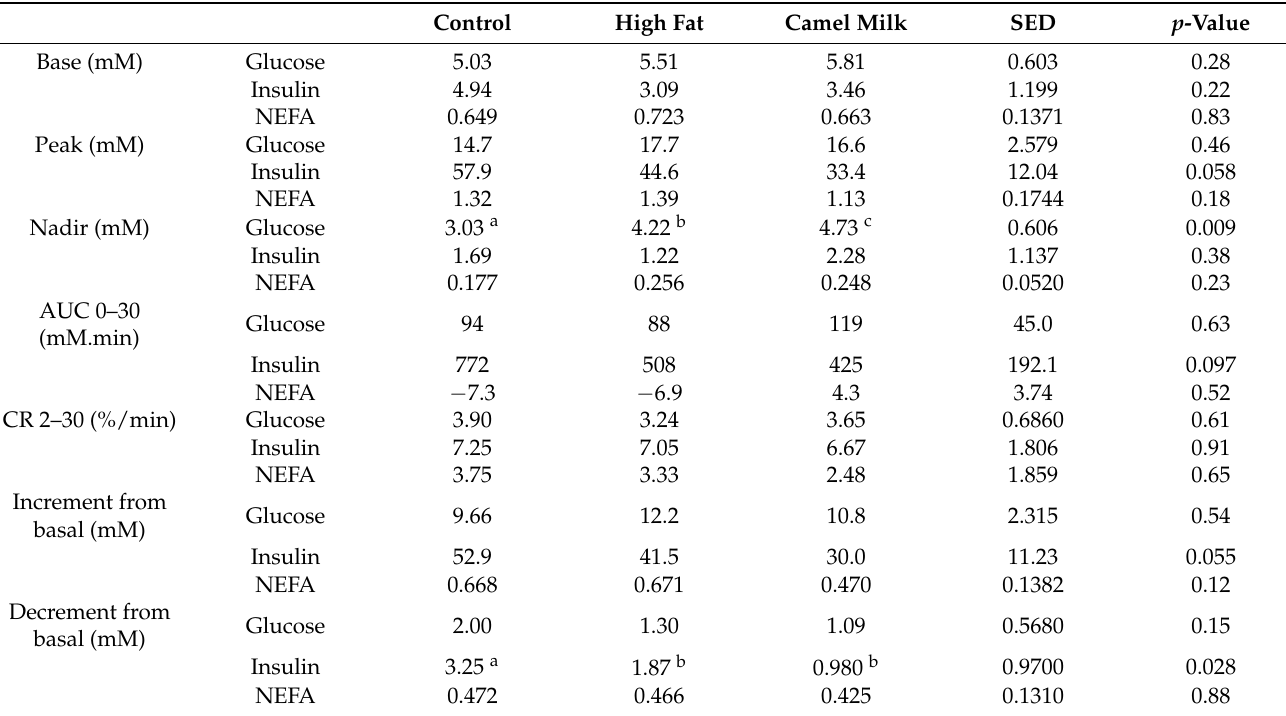
Table 3. Plasma glucose, insulin, and fatty acids parameters derived from intravenous glucose tolerance tests (IVGTT) including basal, peak, nadir and recovery concentrations, area under the curve (AUC), clearance rate (CR), increment and decrement from basal measured in growing female pigs fed either a control ( n = 5), high fat ( n = 5), or camel milk (combination of raw and pasteurized n = 10) diet. Values with different alphabetical superscripts differ statistically ( p < 0.005).